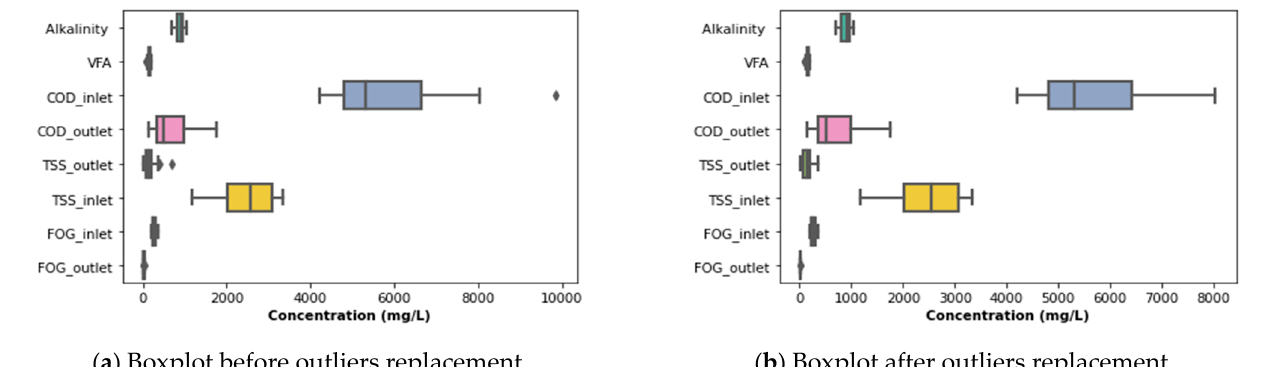
Figure 9. Boxplots of the investigated parameters associated with DEGBR performance.